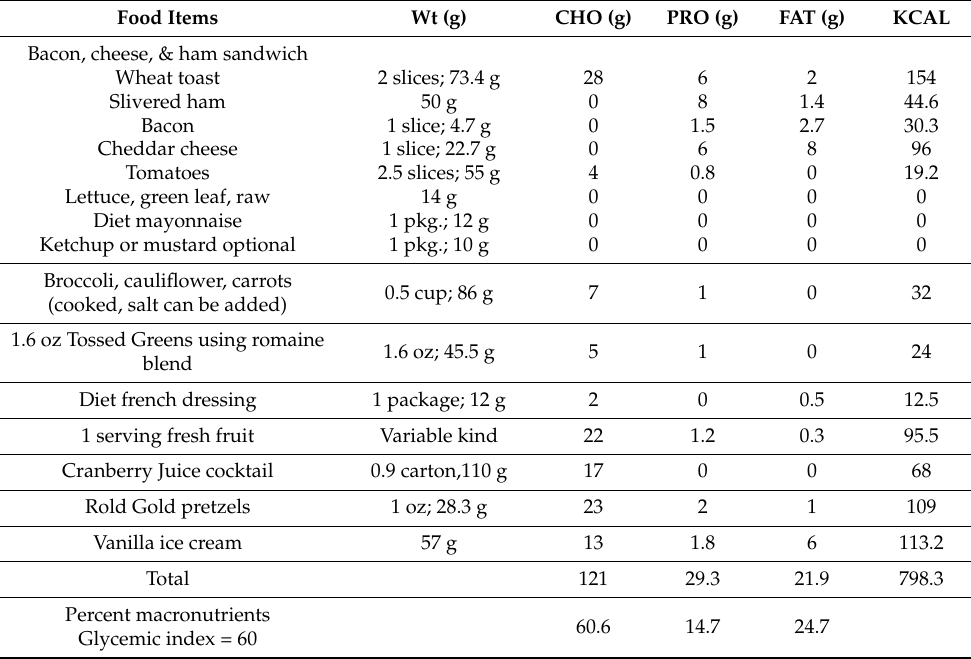
Table 3. Food items, macronutrients, and calories of the afternoon